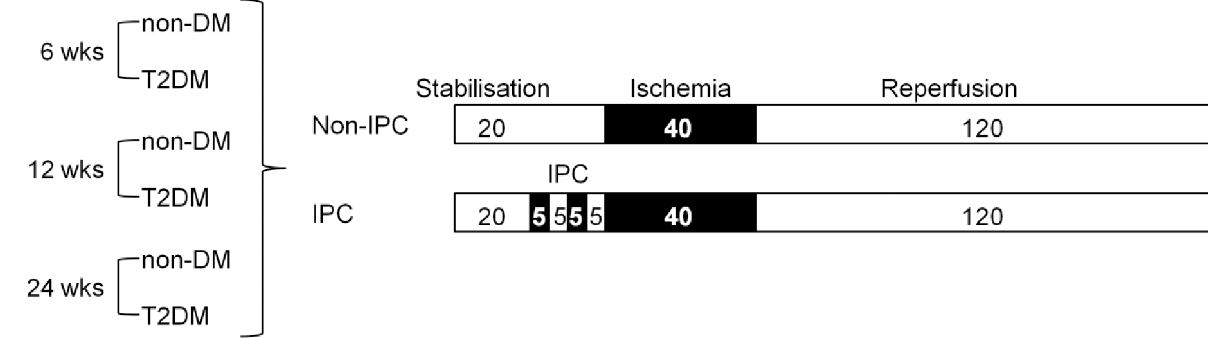
Fig 1. Study design. Overview of experimental groups and